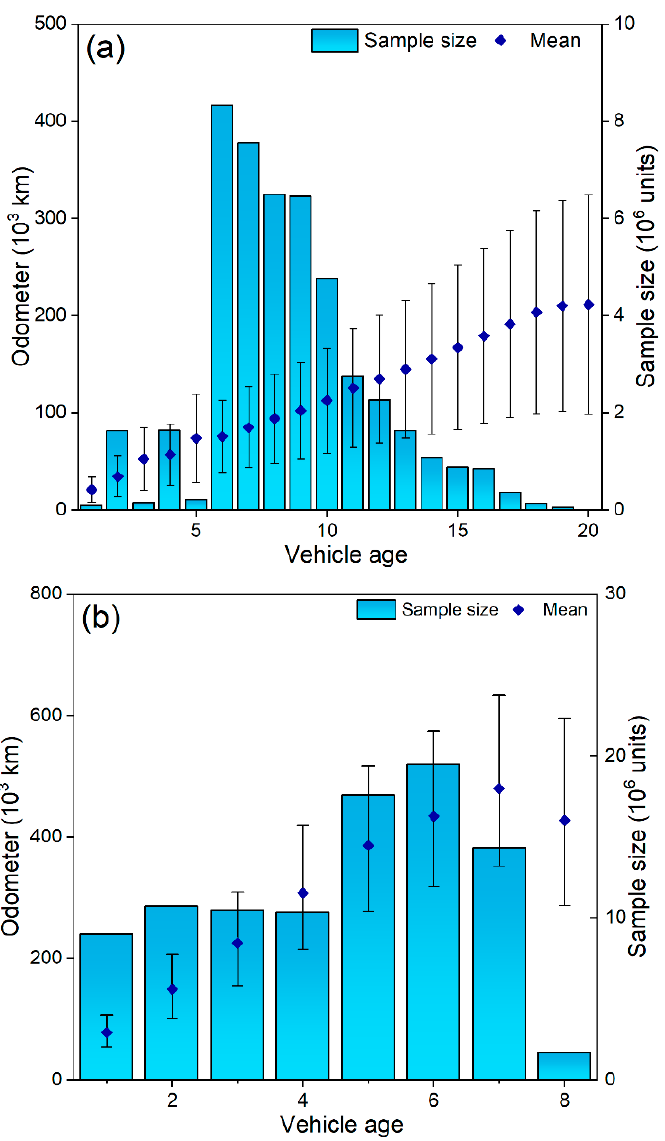
Figure 2. Odometer trends from the I/M database by vehicle age of light-duty ( a ) private cars and ( b ) taxis in 2019.